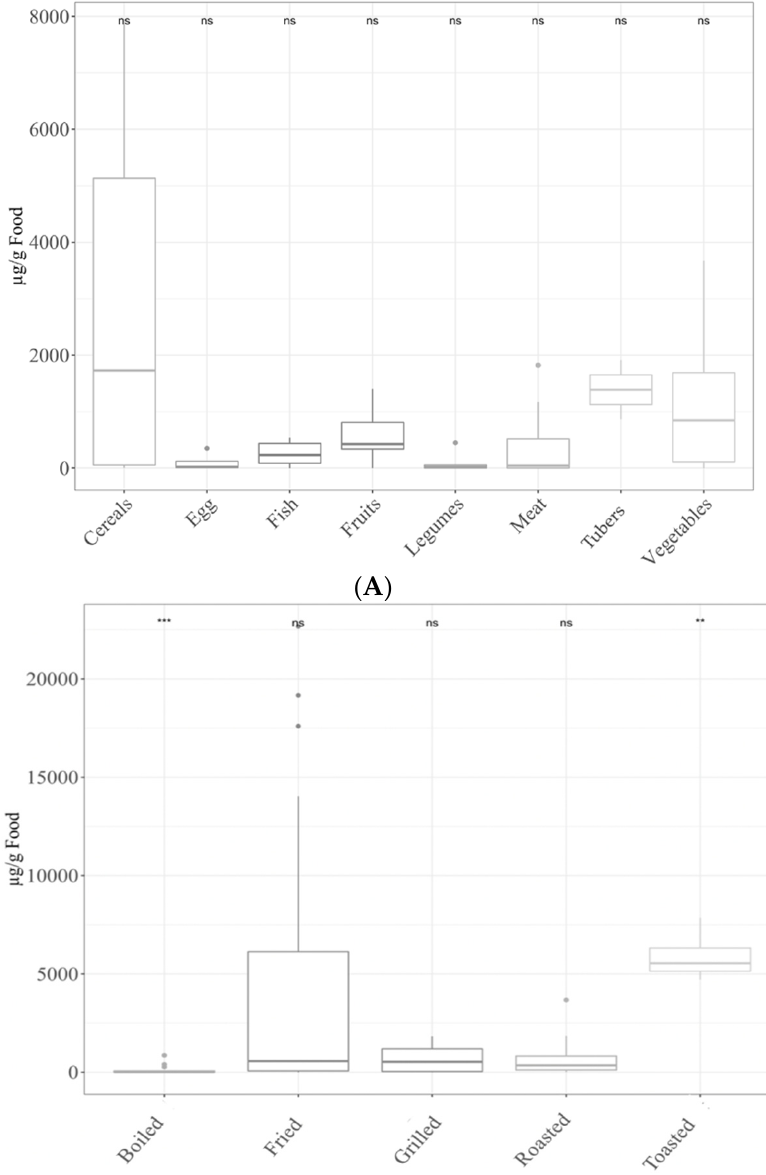
Figure 3. ( A ) Furfural levels in different food groups. Statical analysis was performed via Kruskal– Wallis test. Each of the groups were compared to the average of all of them (i.e., base-mean). Statistic labels: ns: not significant. ( B ) Furfural levels depending on the cooking applied. Statical analysis was performed via Kruskal–Wallis test. Each group was compared to the average of all of them (i.e., base-mean). Statistic labels: **: p < 0.01, ***: p < 0.001, ns: not significant.